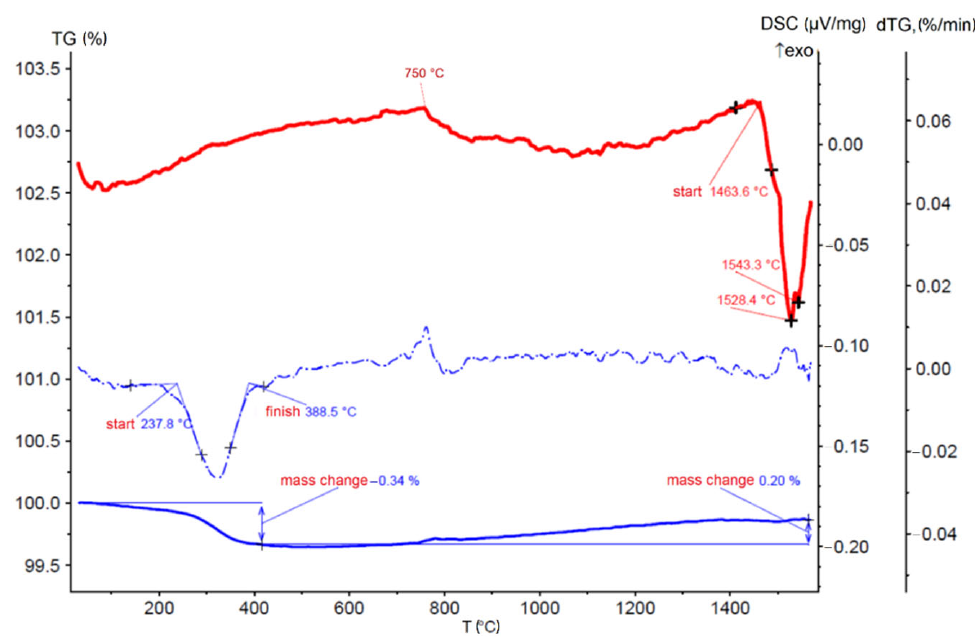
Figure 2. Curves of TGA (solid blue line), DTG (dashed blue line) and DSC (red line) of the NiAl–Cr–Mo–Co sample .